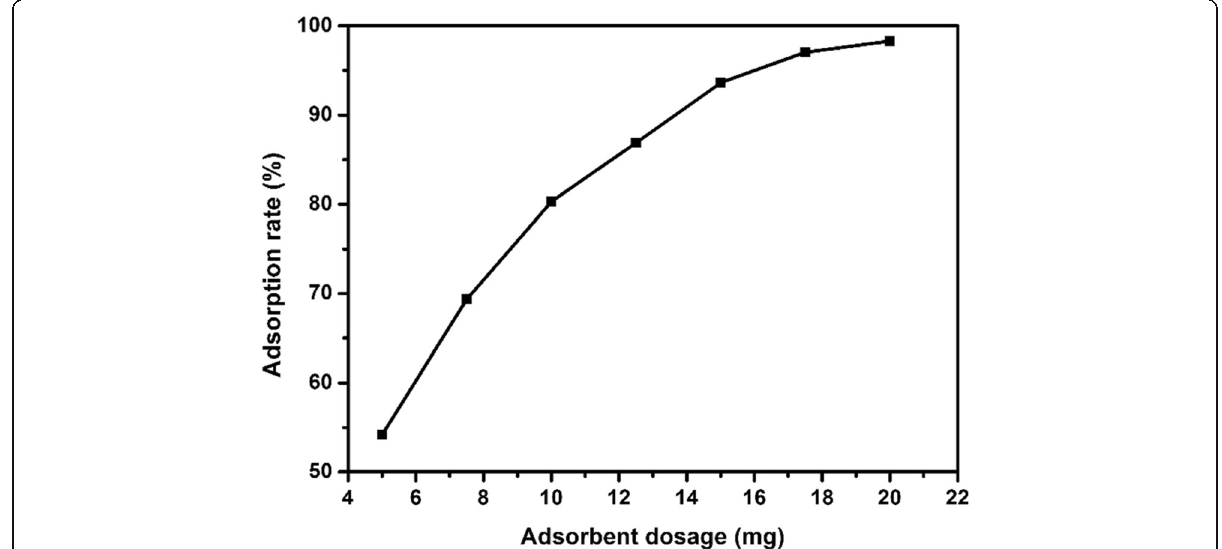
Fig. 7 Effect of different copper sulfide adsorbent dosage on